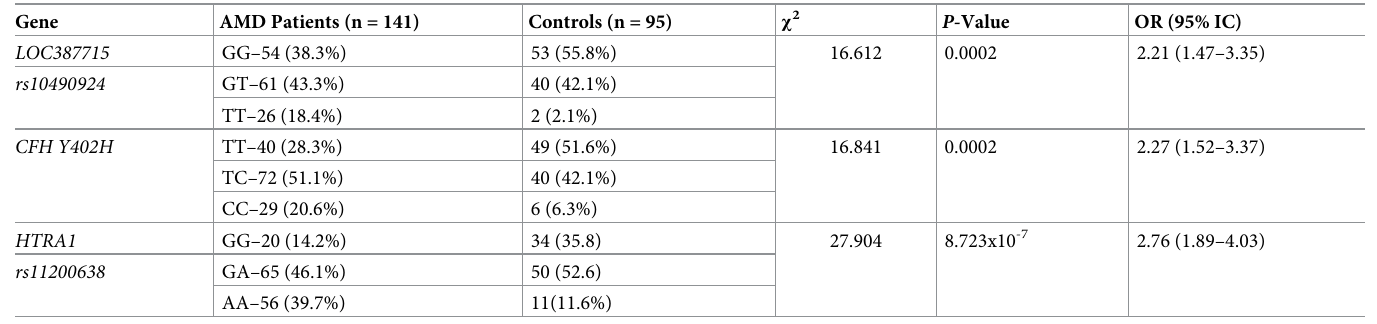
Table 2. Genotype distribution of rs10490924, rs1061170, and rs11200638 between AMD cases and controls. Gene